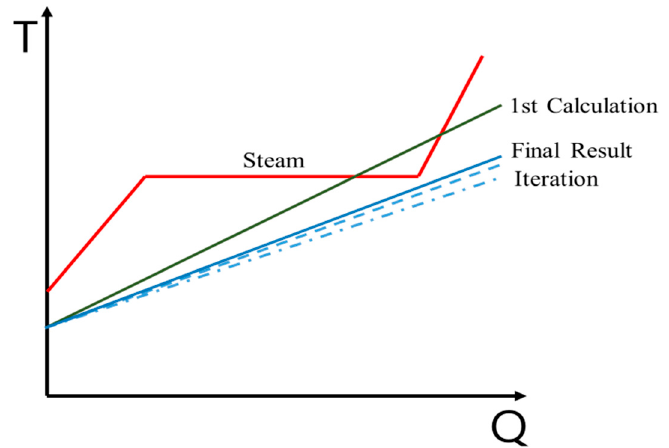
Figure 5. Temperature (T)–heat load (Q) diagram of heat exchanger